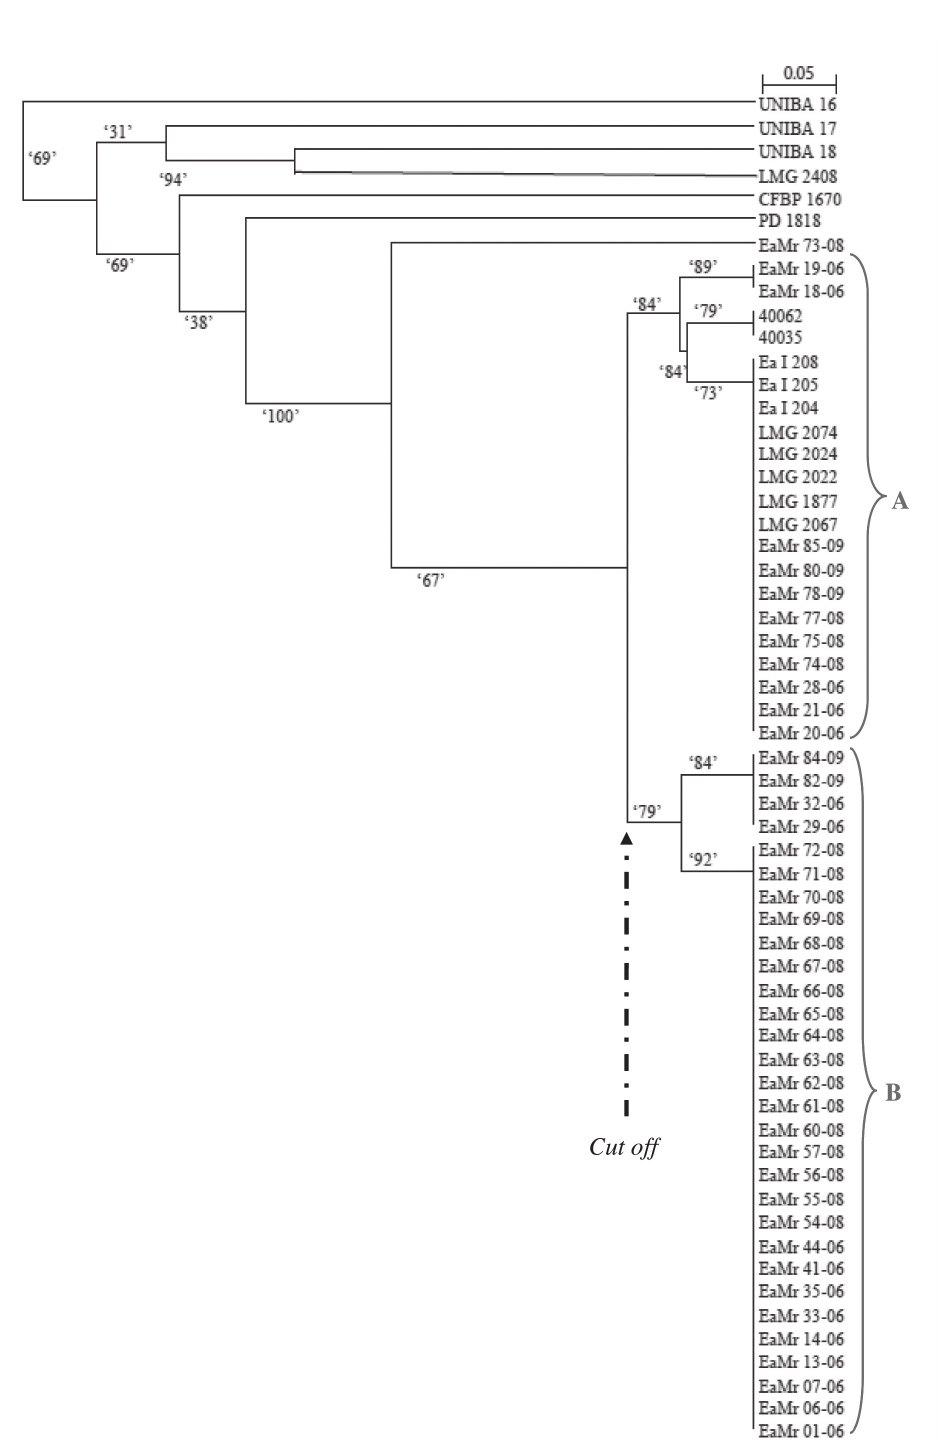
Figure 3. Dendrogram of Erwinia amylovora strains derived from rep-PCR DNA fi ngerprints generated from the BOXA1R primer. Dendrogram was calculated with unweighted pair-group method with average linkages (UPGMA) using the Jaccard’s coef fi cient and the robustness of the tree was assessed by bootstrap